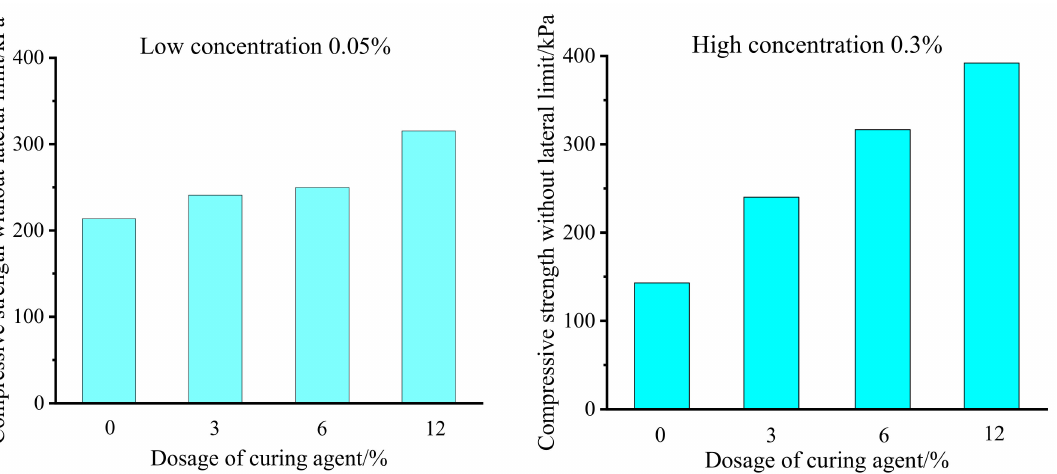
Figure 4. Compressive strength of cured soils with high and low contamination concentrations versus the amount of curing